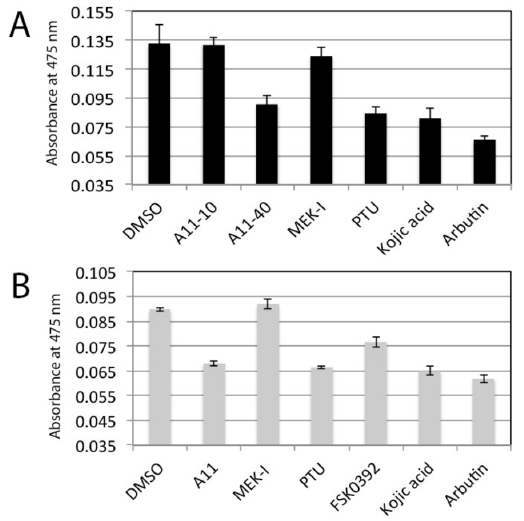
Figure 9. A11 also causes pigment reduction in mammalian melanocytes. ( A ) Cultured mouse melanoma cells B16F10 were treated with different skin-lightening compounds for 24 h. The cells were lysed with KOH and the melanin was measured with spectrophotometer at 475 nm. A11 showed strong reduction of melanin at 40 μ M (A11-40) but no reduction at 10 μ M (A11-10). Several skin-lightening compounds also showed strong reduction of melanin. MEK-I, however, showed no melanin reduction in B16F10 cells; ( B ) Normal human melanocytes were treated with skin-lightening compounds. A11, PTU, kojic acid, and arbutin showed melanin inhibition. Again, MEK-I did not show inhibition at all. FSK0392 is an A11 analog which also showed strong inhibition.